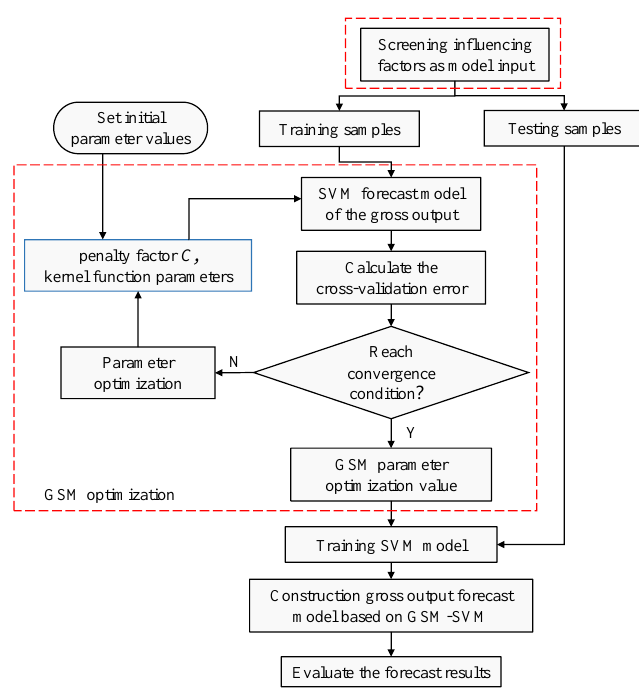
Figure 2. Workflow of GSM-SVM gross output value forecast.